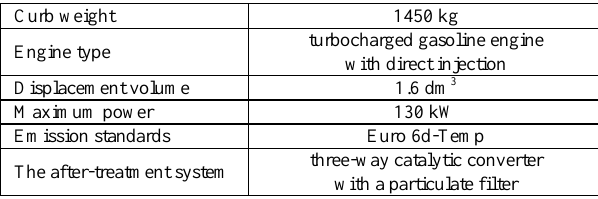
Table 1. Characteristics of the passenger car used in testing